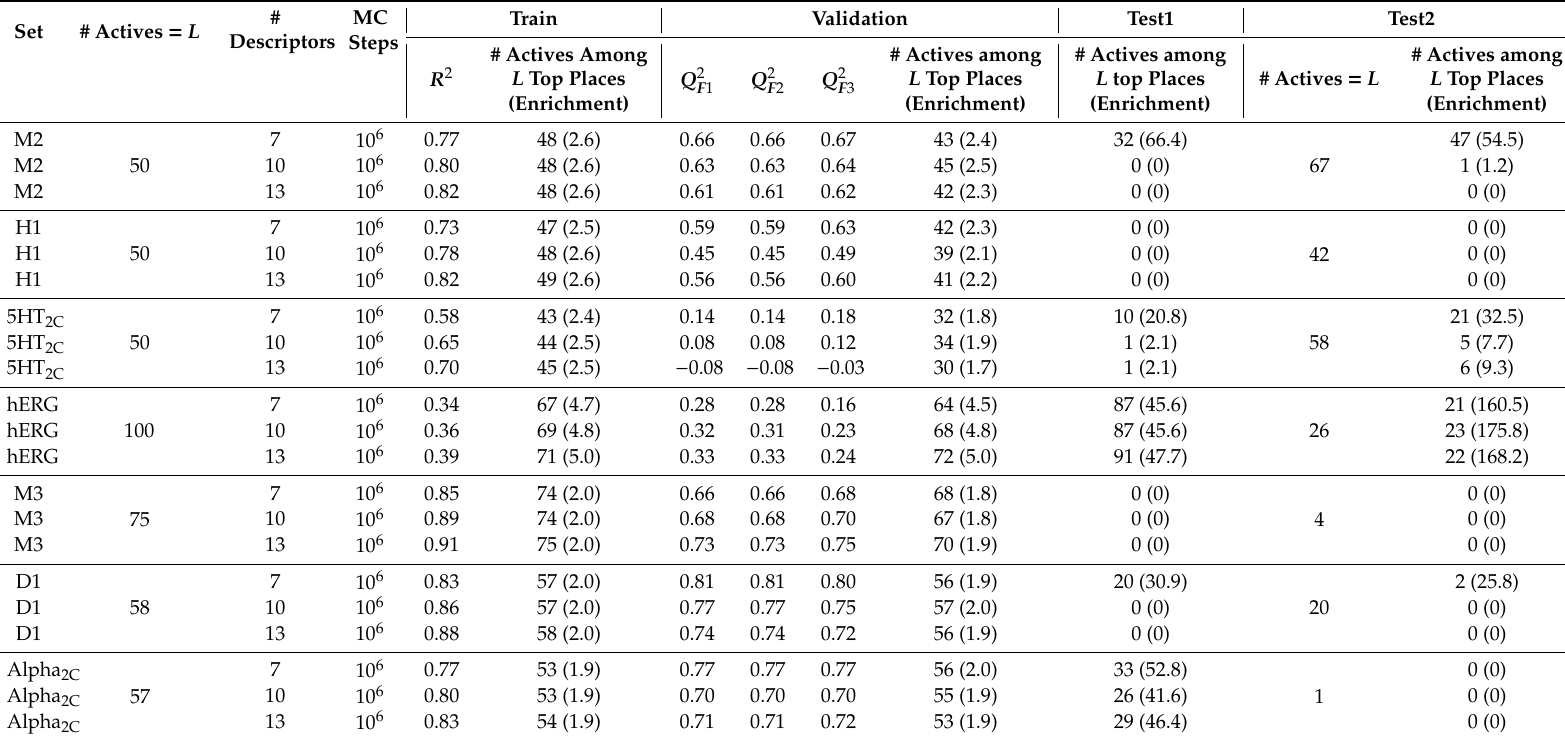
Table 1. Results of the Multiple Linear Regression (MLR)